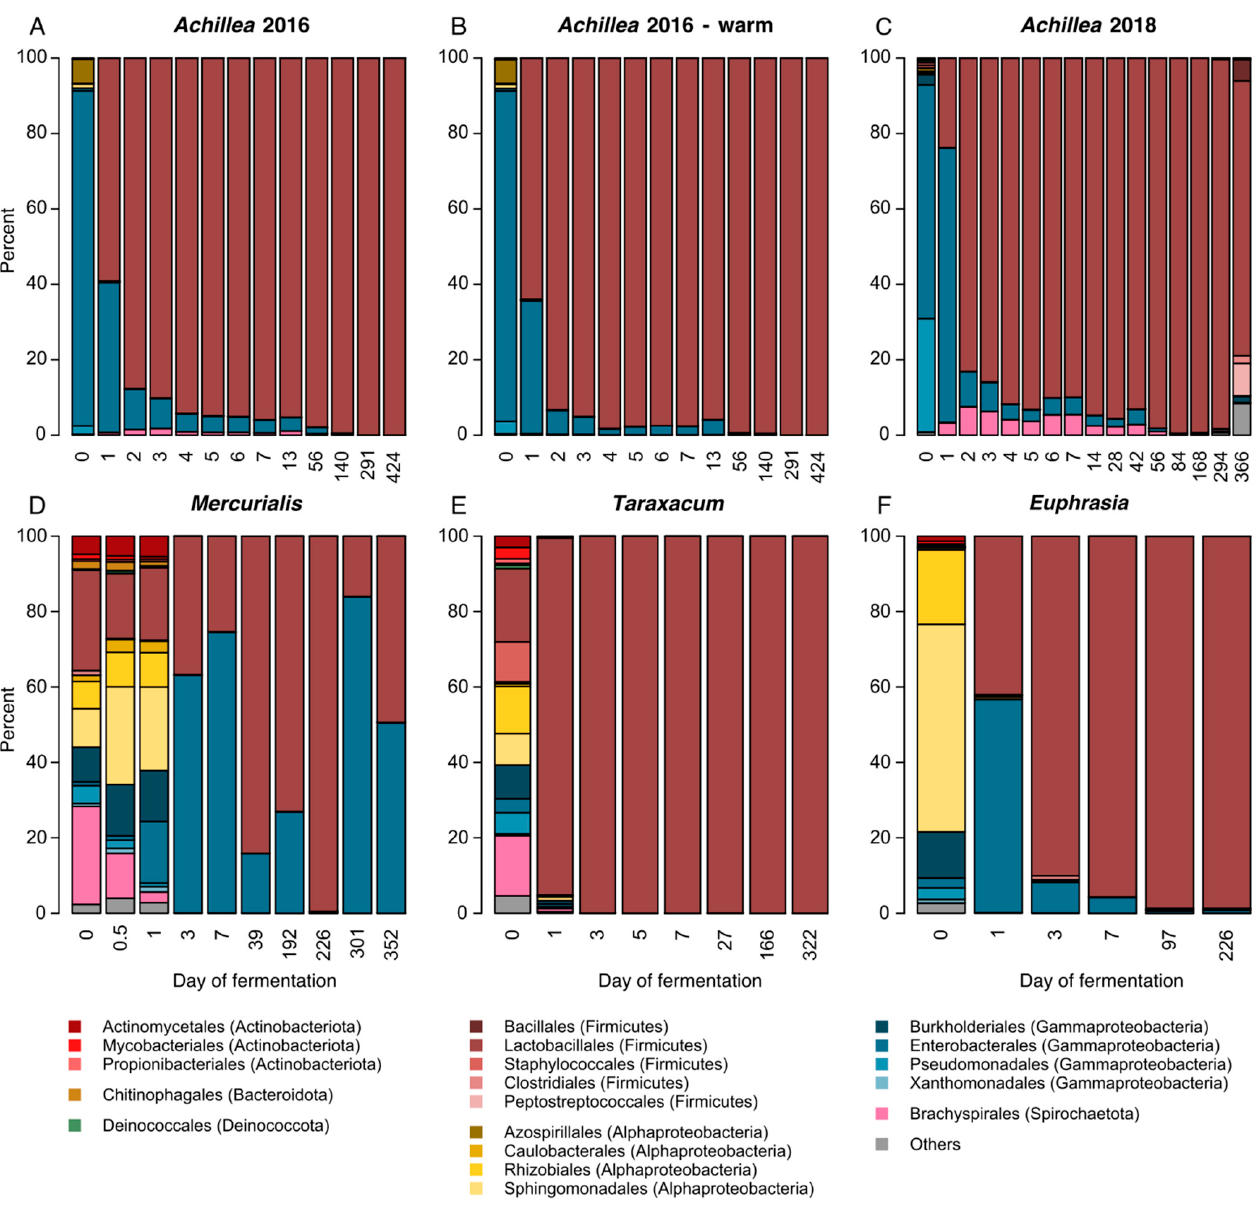
Figure 4. Percentages of the 19 most abundant bacterial orders during the fermentation of Achillea ( A – C ), Mercurialis ( D ), Taraxacum ( E ), and Euphrasia ( F ), according to the GHP. Achillea 2016 was also fermented at permanently warm conditions during the initial 7 days ( B ).